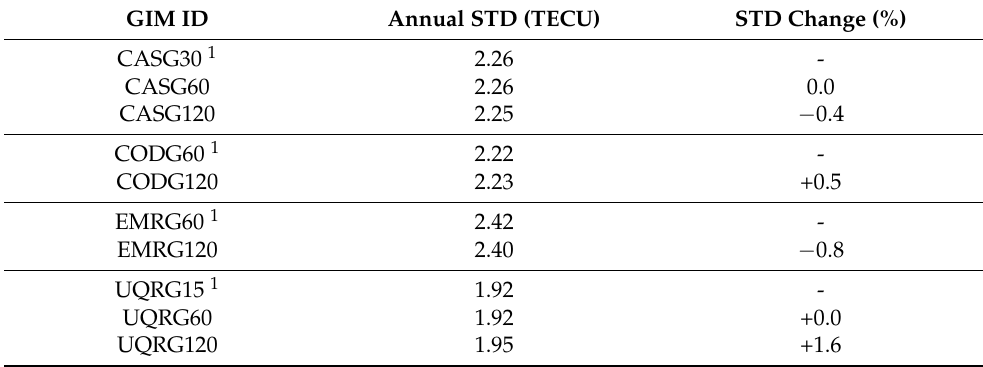
Table 3. Annual STD from Alt-VTEC comparisons for all analyzed GIMs in 2018.